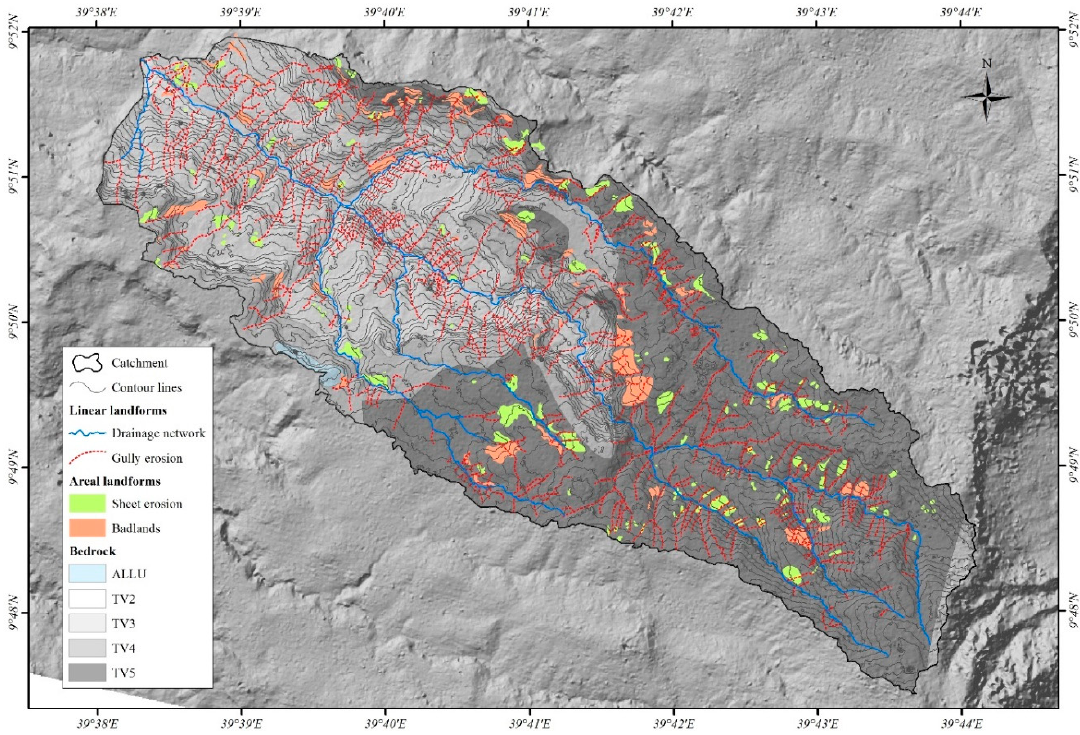
Figure 3. Water erosion inventory map.